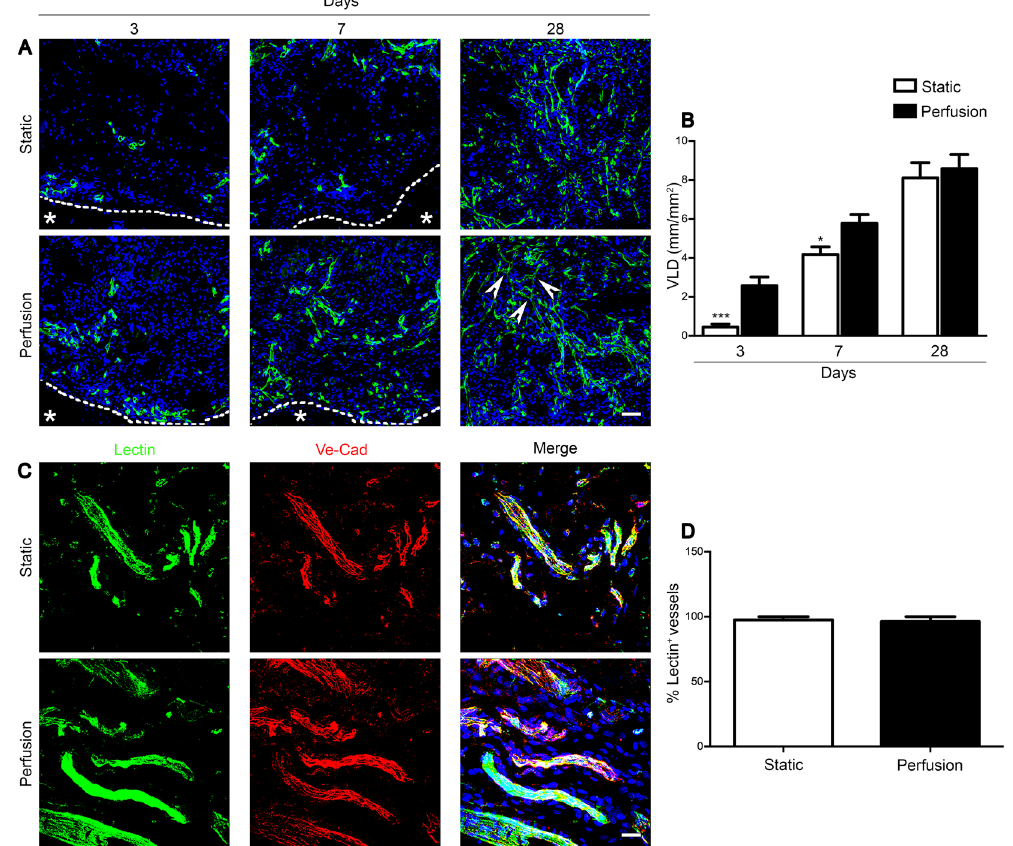
Figure 4. Perfusion accelerated in vivo vascularization of engineered tissues. ( A ) Representative immunofluorescence images stained for endothelial cells (CD31; green). Dashed lines outline the border between the patch and rat tissue (identified by the * ). White arrows indicate branching points in perfusion condition at 28 days. Scale bar = 50 μ m. ( B ) VLD quantification normalized over the analysed area. ( C ) Representative immunofluorescence images stained for EC (Ve-Cad; red) and intravascular marker (lectin; green) injected prior to sacrifice at 28 days. Nuclei were stained with DAPI (blue). Scale bar = 20 μ m. ( D ) Percentage of the total vessels that resulted perfused by blood (lectin + ) at the moment of sacrifice. * p < 0.05, *** p < 0.001. (n donor =